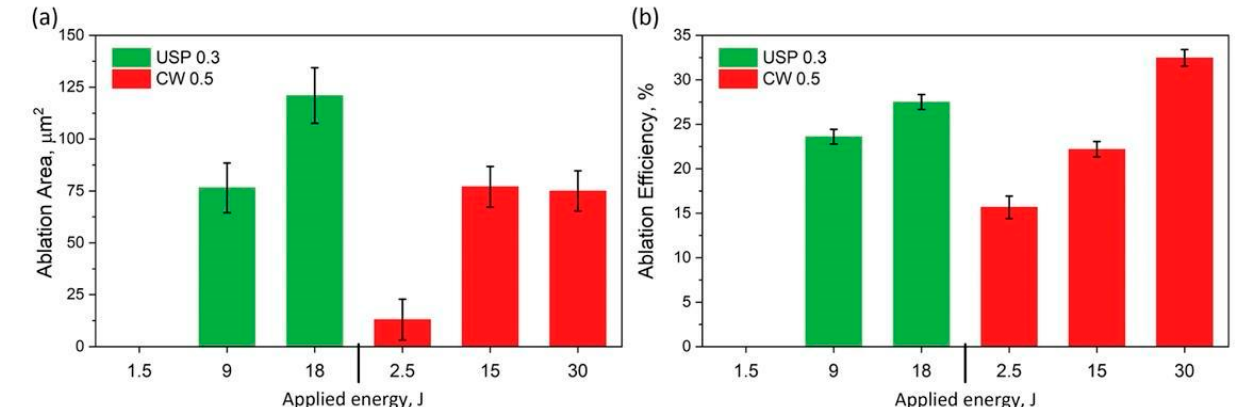
Figure 7. ( a ) Ablation area and ( b ) ablation efficiency as a function of applied energy of USP and CW laser radiation for different times of exposure (5, 30 and 60 s) and laser power (0.3 W, 0.5 W), shown as applied energy.